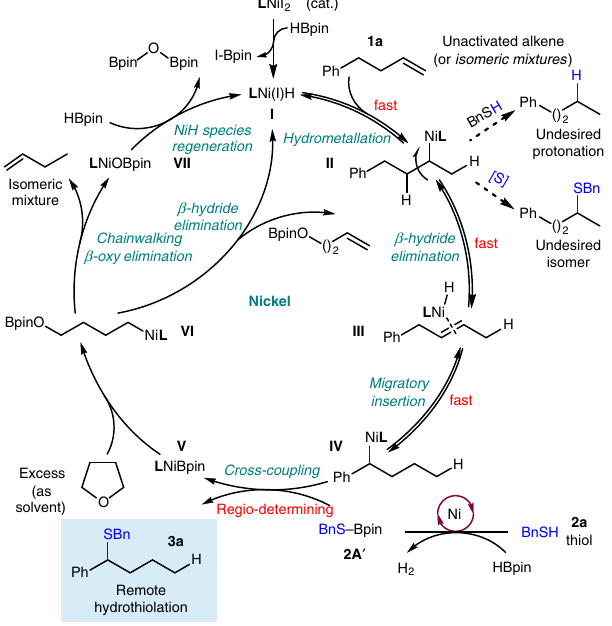
b Switch to terminal selectivity: anti -Markovnikov hydrothiolation (condition B)